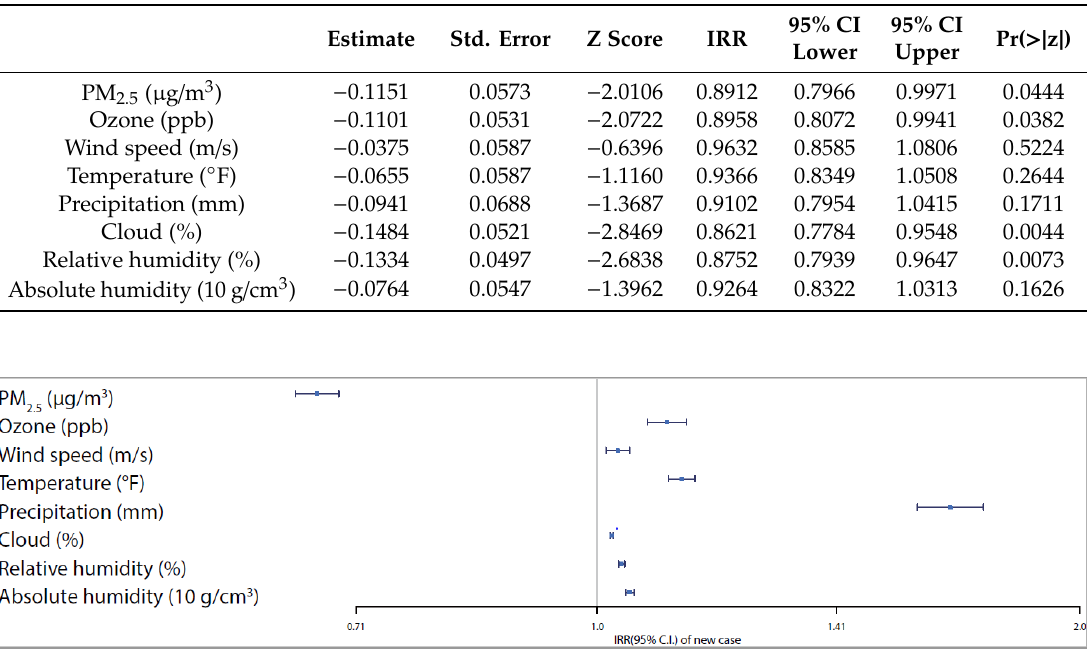
Figure 6. Trend and lag-case adjusted IRRs (and 95% CIs) associated with each environmental predictors for new COVID-19 related deaths.